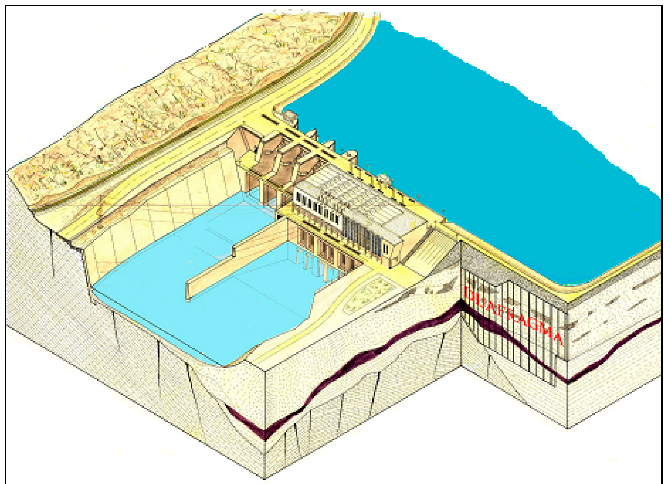
Figure 4. The position of the diaphragm—three-dimensional view of HEPP Mostar [13].